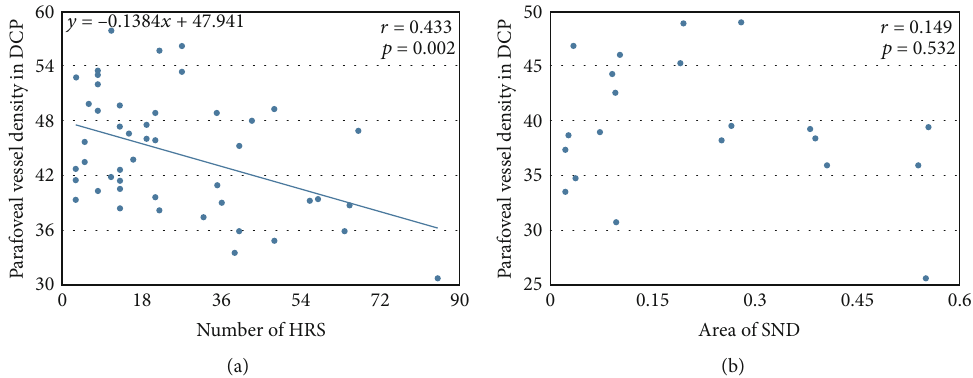
Figure 4: (a) Scatterplots illustrating the linear associations between the parafoveal vessel density in the deep capillary plexus (DCP) and the numbers of hyperre fl ective retinal spots (HRS) in all eyes. (b) Scatterplots illustrating the linear associations between the parafoveal vessel density in DCP and the area of SND in SND+ eyes. A value of p < 0 : 05 was considered statistically signi fi cant. r , correlation coe ffi cient from the Spearman rank correlation